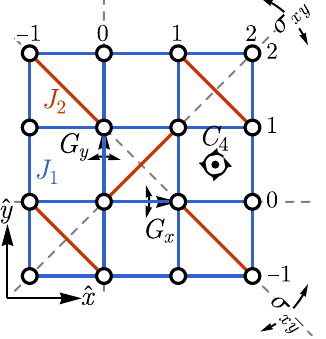
FIG. 5. The ideal Shastry-Sutherland lattice, deformed from Fig. 1(a). Each site i can be labeled by a Cartesian coordinate ð x; y Þ . The x and y coordinates are calibrated on the top and right, respectively. The displacement vectors ˆ x ¼ ð 1 ; 0 Þ and ˆ y ¼ ð 0 ; 1 Þ are defined to connect nearest-neighbor sites. J 1 and J 2 couplings are assigned to the nearest-neighbor (in blue) and dimer (in red)